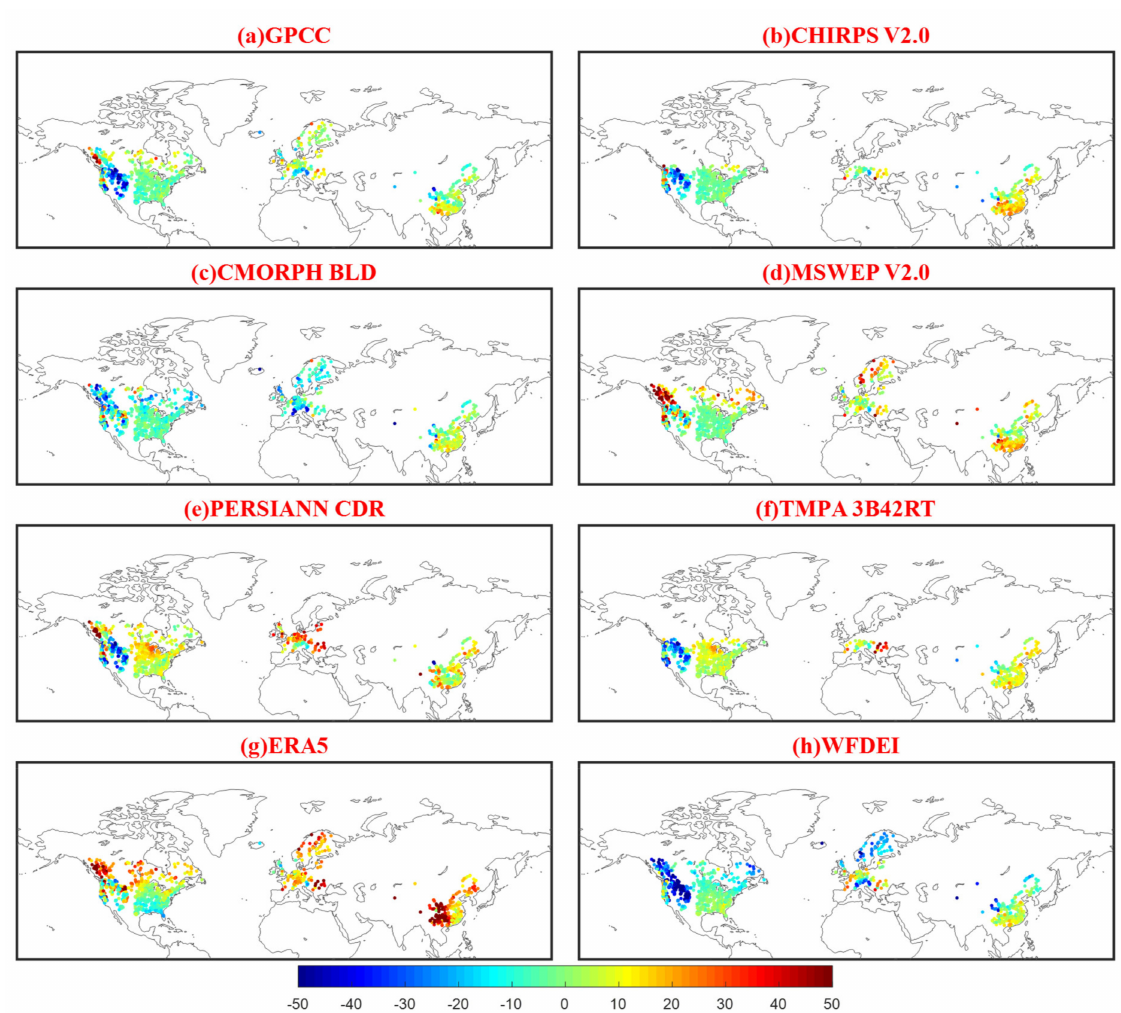
Figure A1. Spatial patterns of RB for the eight PPs using gauge-observed precipitation from 1382 catchments as a reference. Each data point represents a catchment